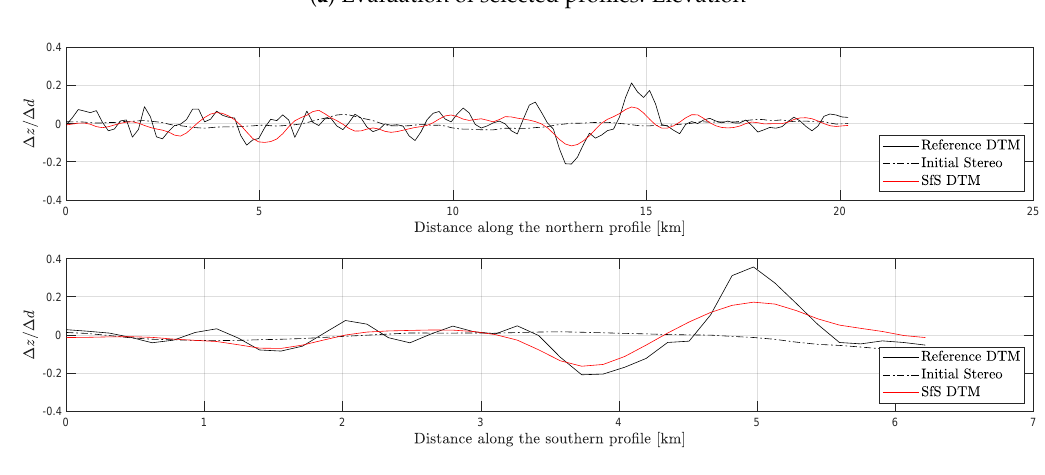
Figure 12. ( a ) Elevation of the northern and southern profile marked in Figure 11. The elevations of the initial DTM (black dotted) and the SfS DTM (red) are compared to the reference DTM (black). ( b ) First derivative of the reconstructed surface along the same profiles. The derivatives of the initial DTM (black dotted) and the SfS DTM (red) are compared to the derivative of the reference DTM